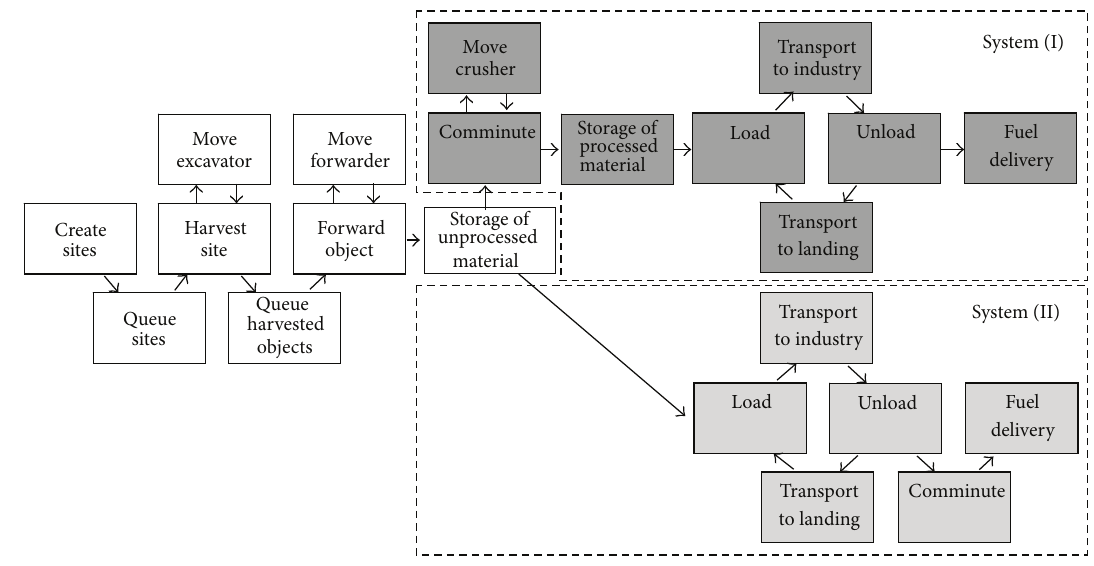
Figure 2: Flow diagram of the supply chain model showing the two systems tested, (I) and